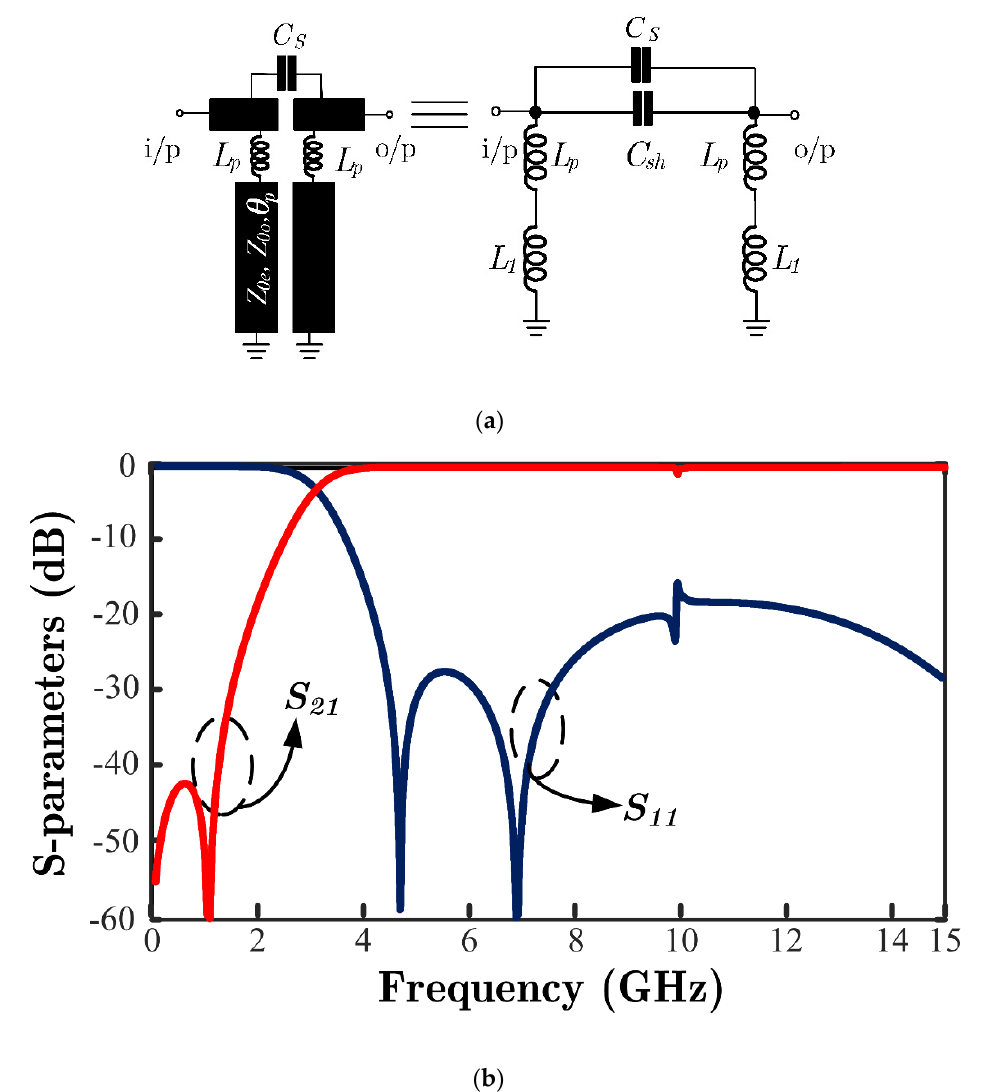
Figure 2. The design of the HPF: ( a ) The schematic of the HPF and ( b ) frequency response of the HPF with compensated inductors ( L p = 0.68 nH) from computer simulations.